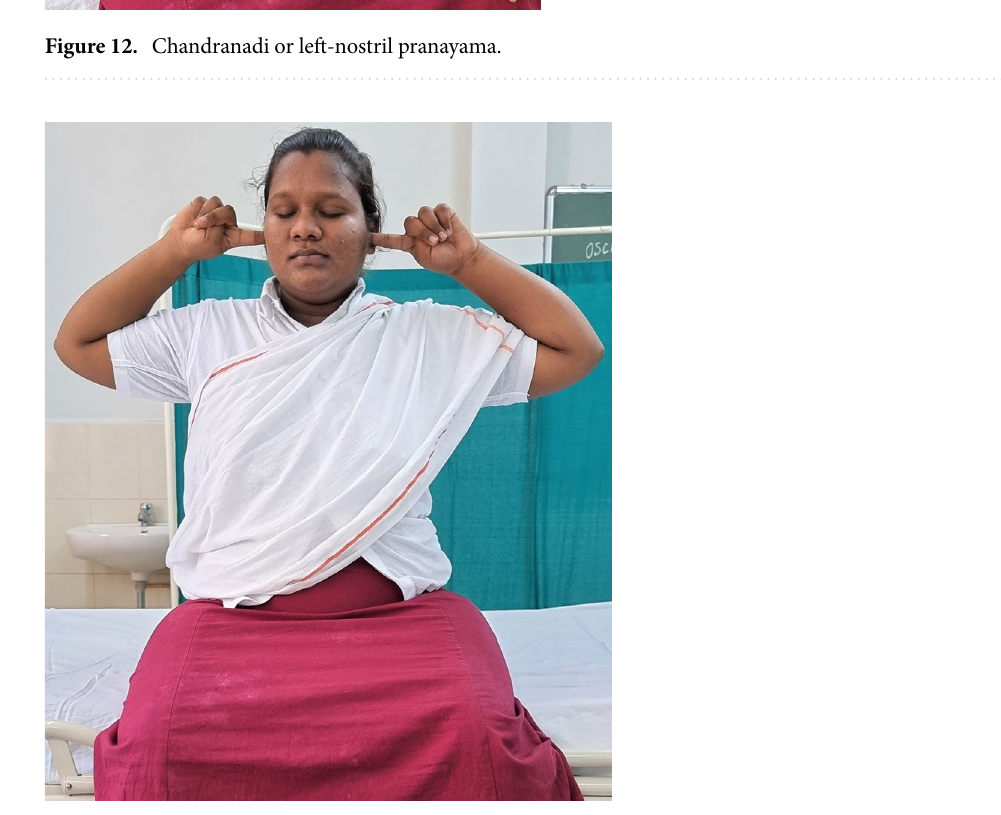
Figure 13. Bhramari or humming-bee